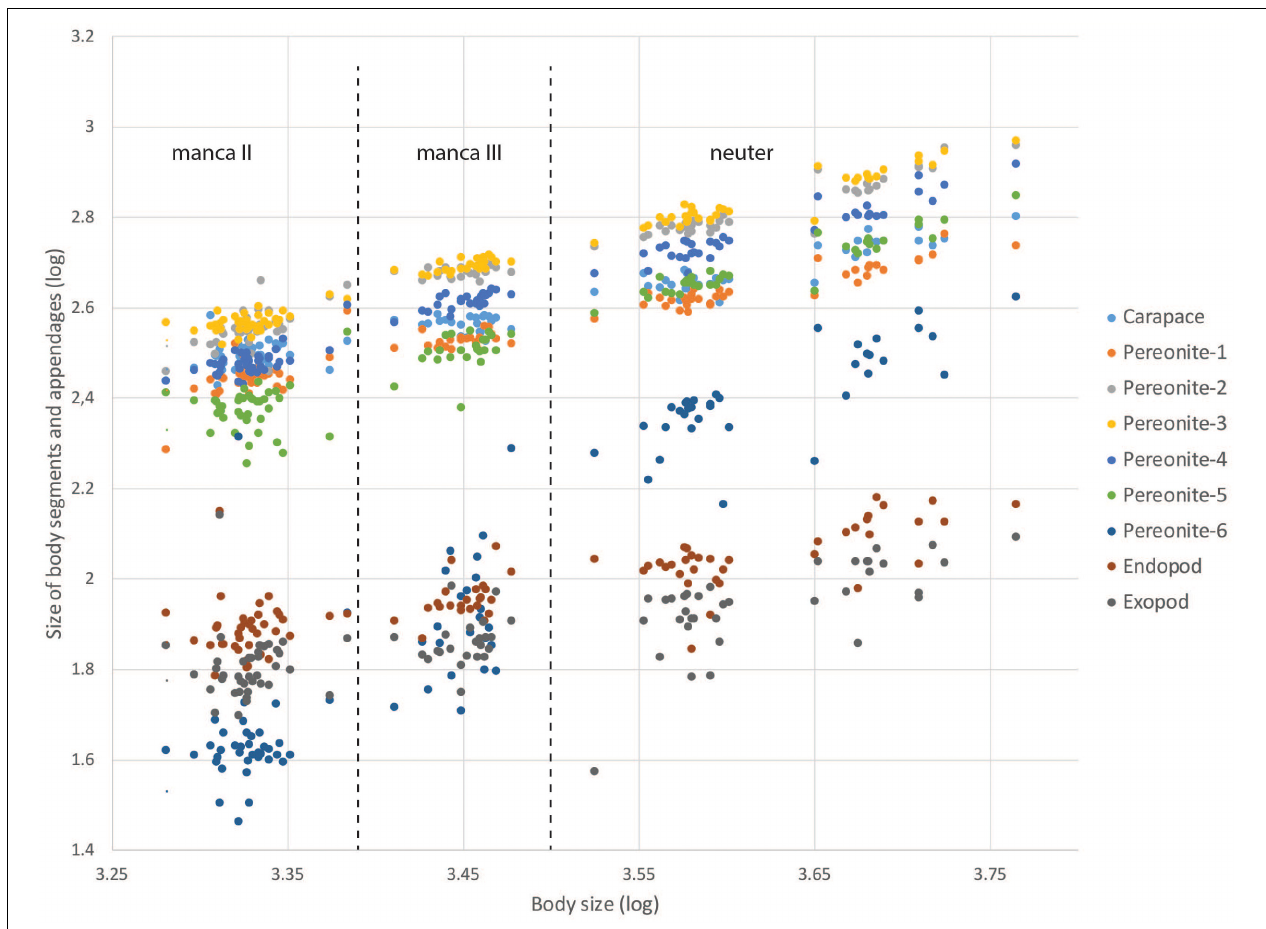
FIGURE 15 | Scatterplot of Spearman correlation of nine morphological characters (body length, pereonites 1–6 length, uropodal exopod and endopod length) of the three developmental stages (manca-2, manca-3, neuter) of Hamatipeda mojito .